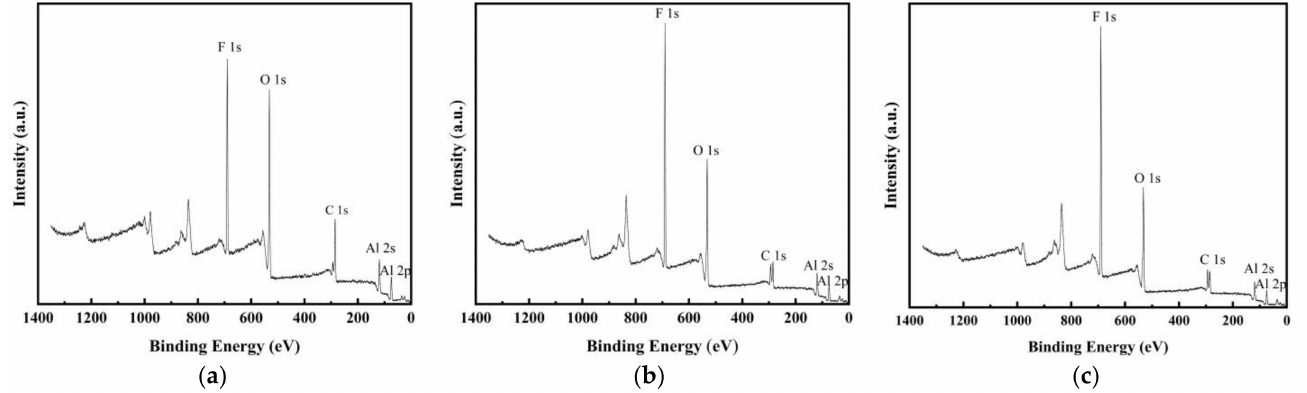
Figure 4. XPS spectra for ( a ) nAl@2.5%PFPE particles, ( b ) nAl@5.0%PFPE particles, and ( c ) nAl@7.5%PFPE particles.